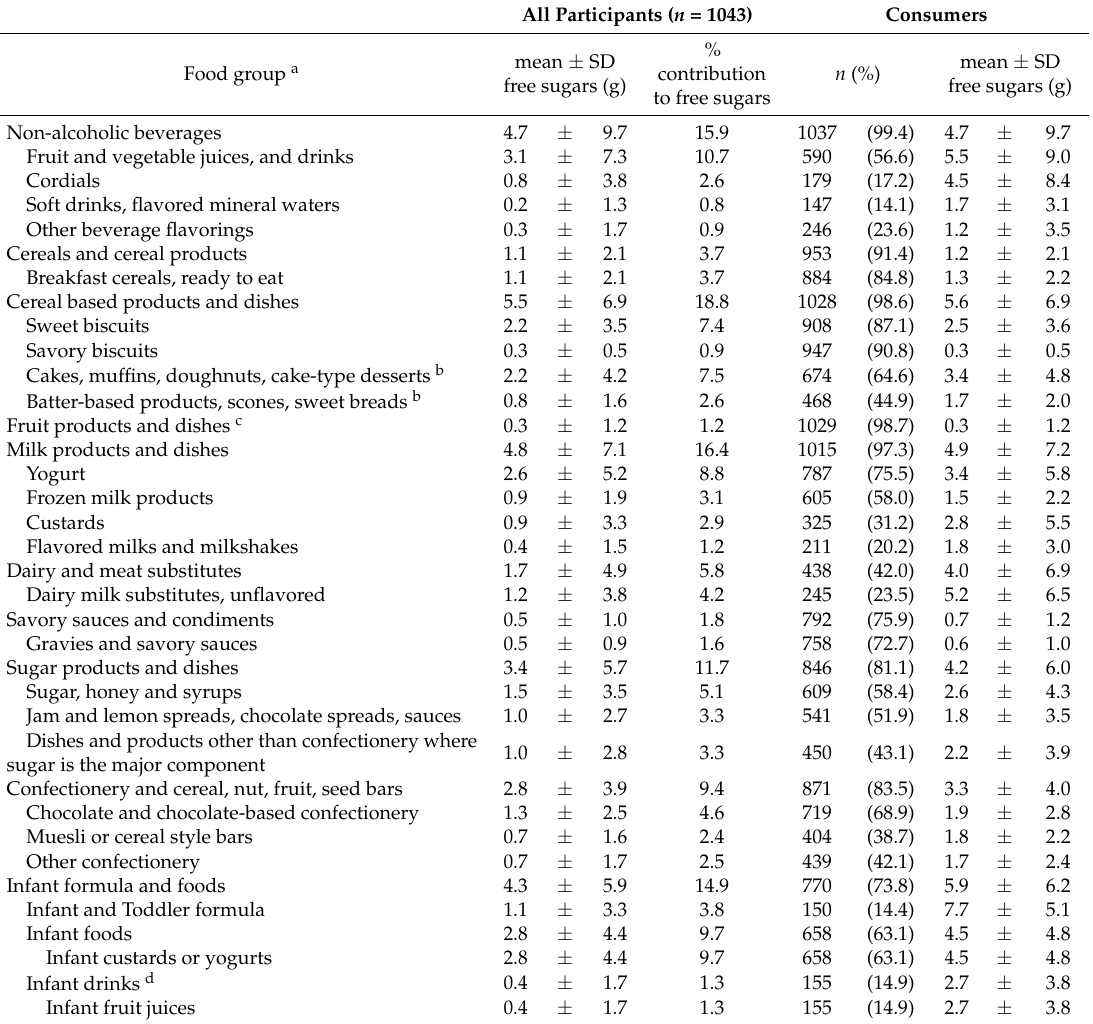
Table 3. Food group contributions to free sugars intakes at 2 years of